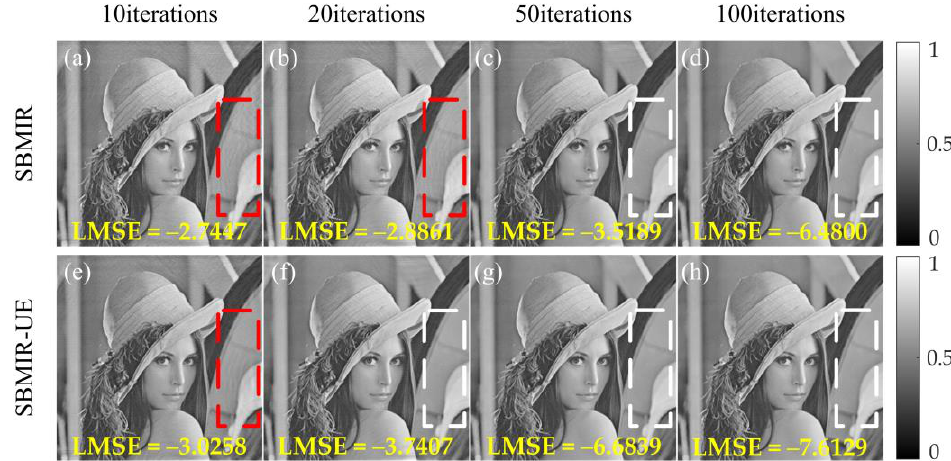
Figure 3. The reconstructed maps after 10, 20, 50 and 100 iterations, respectively, using ( a - d ) SBMIR and ( e - h ) SBMIR-UE.